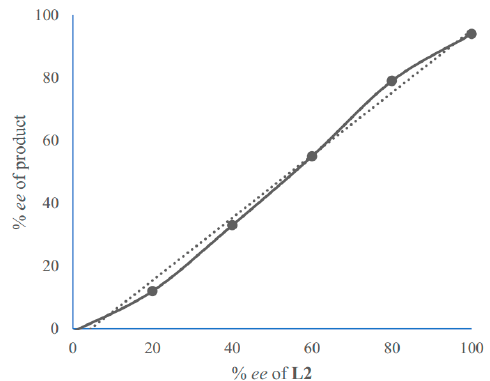
Figure 4. Linear relationship between ee of L2 and ee of product 2 a.